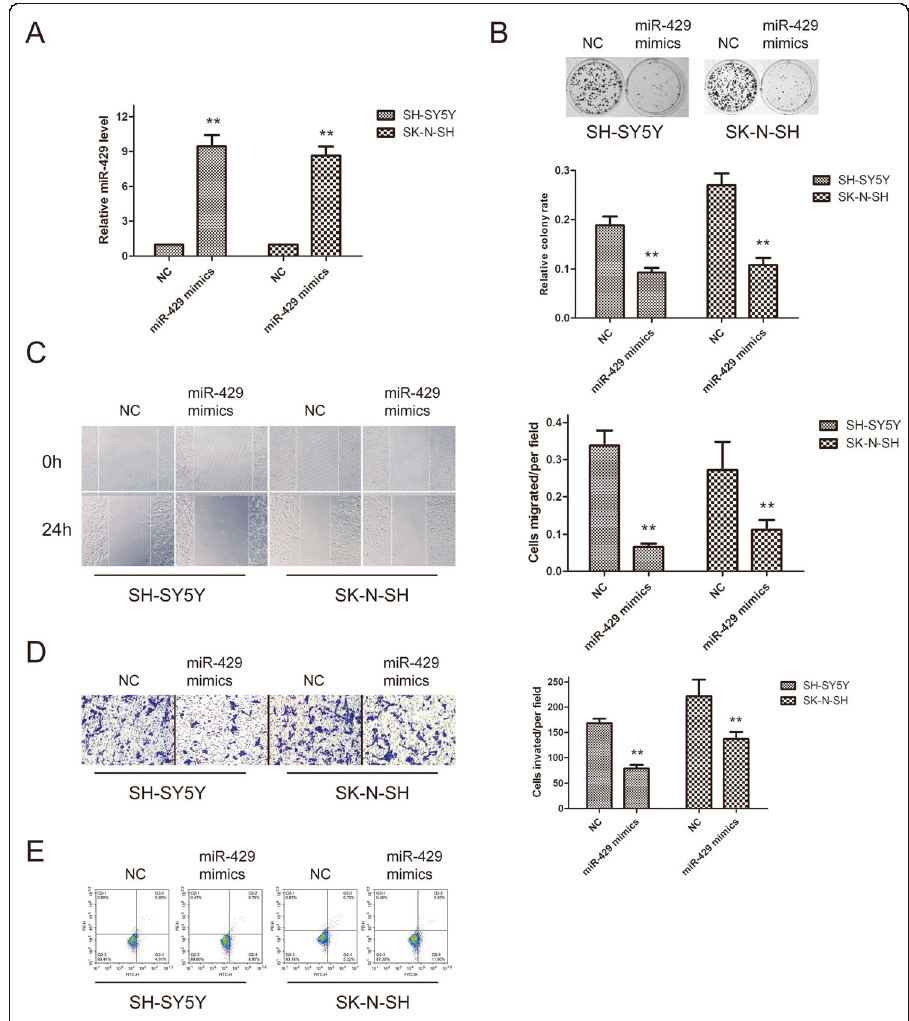
Fig. 3 MiR-429 overexpression blocked the proliferation, migration and invasion of neuroblastoma cells in vitro. a – Overexpression of miR-429 in SH-SY5Y and SK-N-SH cells transfected with the miR-429 mimic. b – Colony formation assays were applied to determine the effect of miR-429 overexpression on SH-SY5Y and SK-N-SH cell proliferation ability. c and d – Wound-healing ( c ) and Transwell ( d ) assays were employed to examine the effect of miR-429 overexpression on the migration capacity of SH-SY5Y and SK-N-SH cells. e – The percentage of apoptotic cells was determined by flow cytometry. Error bars represent the means ± SEM of at least three independent experiments. n.s.: not significant; * p <0.05 and ** p <0.01 vs. the control